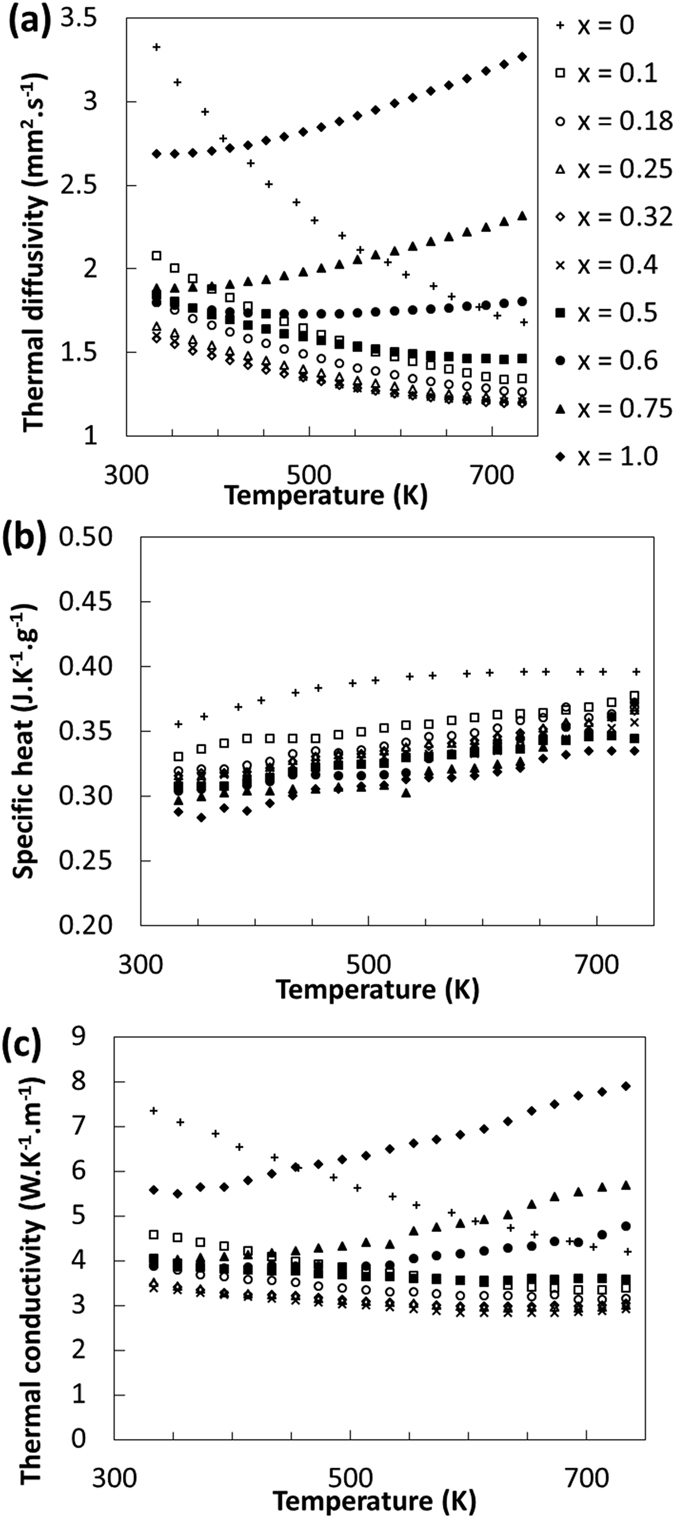
Thermal transport properties of CoSbS1−xSex doped with Te.(a) Thermal diffusivity,(b) Heat capacity, and(c) Total thermal conductivity as a function of x and the temperature of measurement.